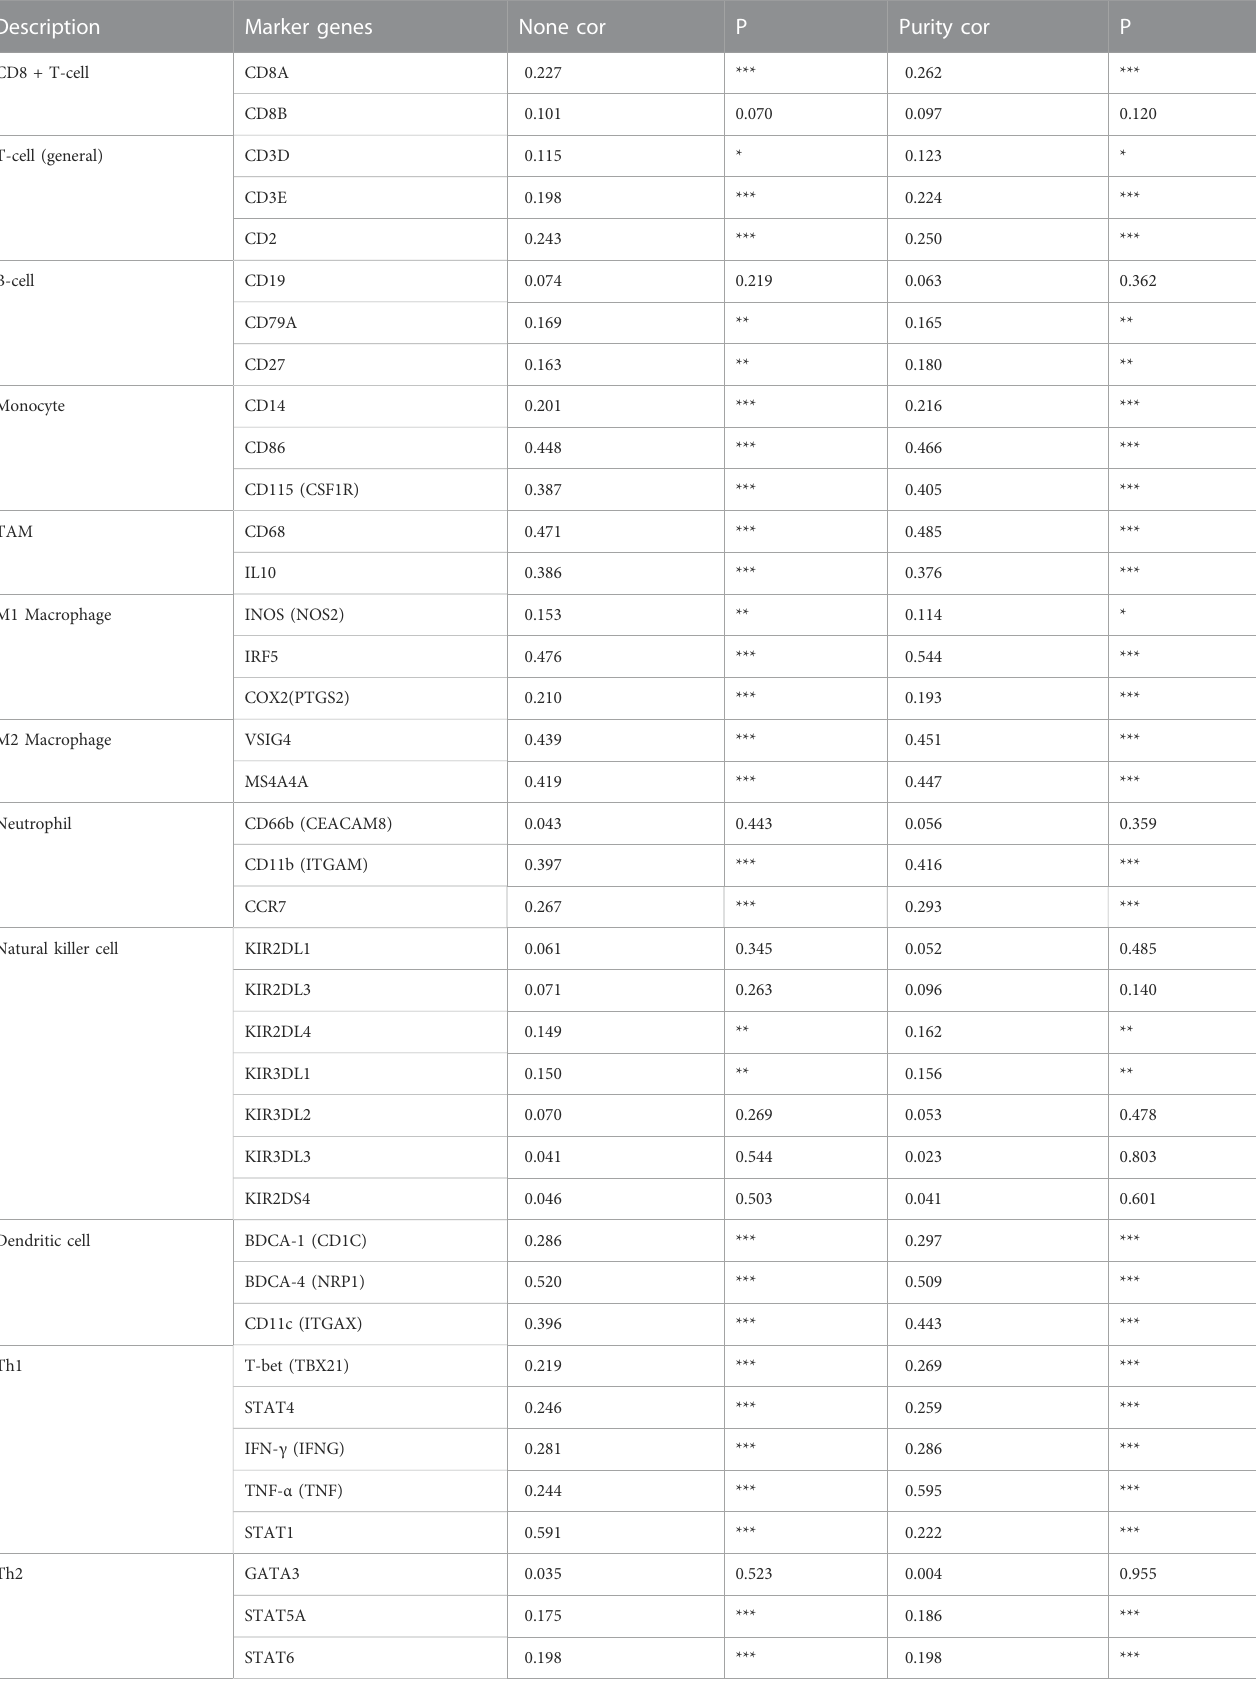
TABLE 3 Correlation analysis between KNL1 and gene markers of immune cells in TIMER.